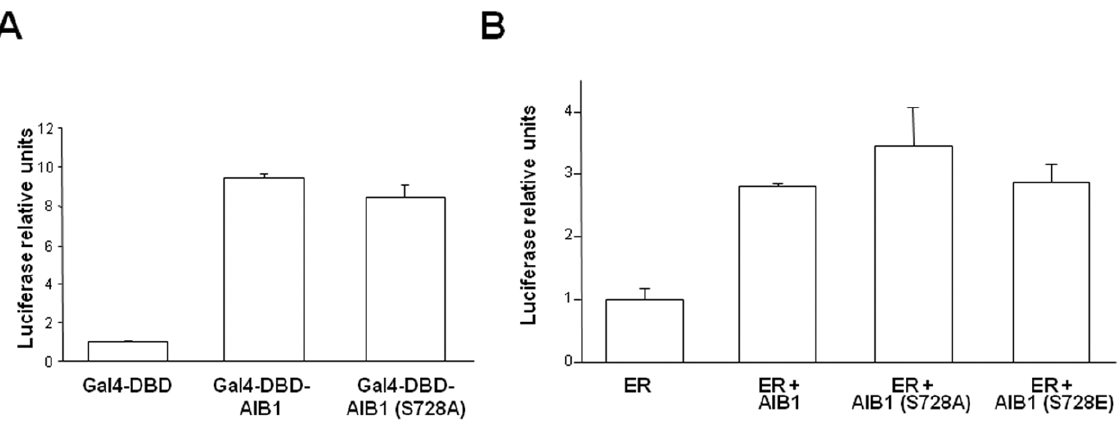
Figure 11. AIB1 phosphorylation at Serine 728 regulates its coactivation capacity. (A) To measure AIB1-dependent transcriptional activity, COS-1 cells were transfected with 500 ng of reporter gene (5 6 UAS-luciferase), 20 ng of tk-lacZ and 25 ng of empty vector pCMX-Gal4-DBD (control, C) or 46.5 ng of pCMX-Gal4-DBD-AIB1 wild type or mutant. 30 hours after the transfection cells were arrested at mitosis with nocodazole (150 ng/ml) for 17 hours. Finally, cells were lysed with passive lysis buffer (Promega) and tested for luciferase activity and normalized against b -gal activities in a luminometer (Berthold Detection Systems). Results are presented as relative units to the control cells as mean values 6 S.E. (B) To measure AIB1- dependent coactivation, COS-1 cells were transfected with the luciferase reporter ERE2-tk-luciferasa and vectors expressing ER a , AIB1 or the mutated AIB1 (S728A) or (S728E). Cells were arrested at mitosis similarly to (A) and treated with 50 nM 17- b -estraxdiol during the last 5 hours.